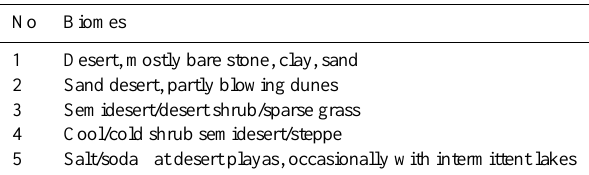
Table 2. Olson ecosystem biomes selected for the dust emission